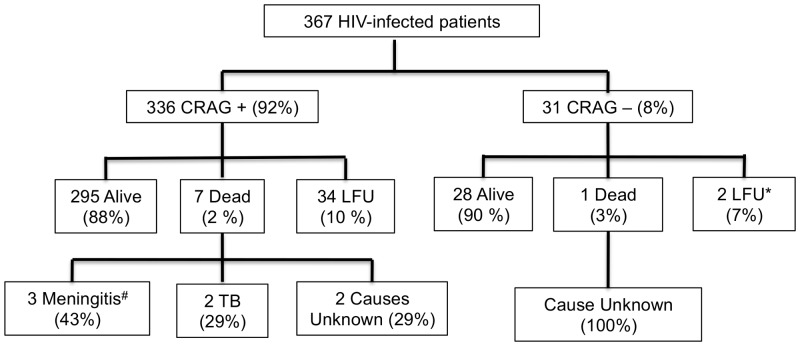
One-Year Follow Up of 367 HIV-Infected Patients, Addis Ababa, Ethiopia.Legend: *No clinic Follow-Up in ≥6 months, 16 patients with no follow up at all; #1 received treatment for CM; CRAG, serum cryptococcal antigen; CM, cryptococcal meningitis; LFU, loss to follow-up.